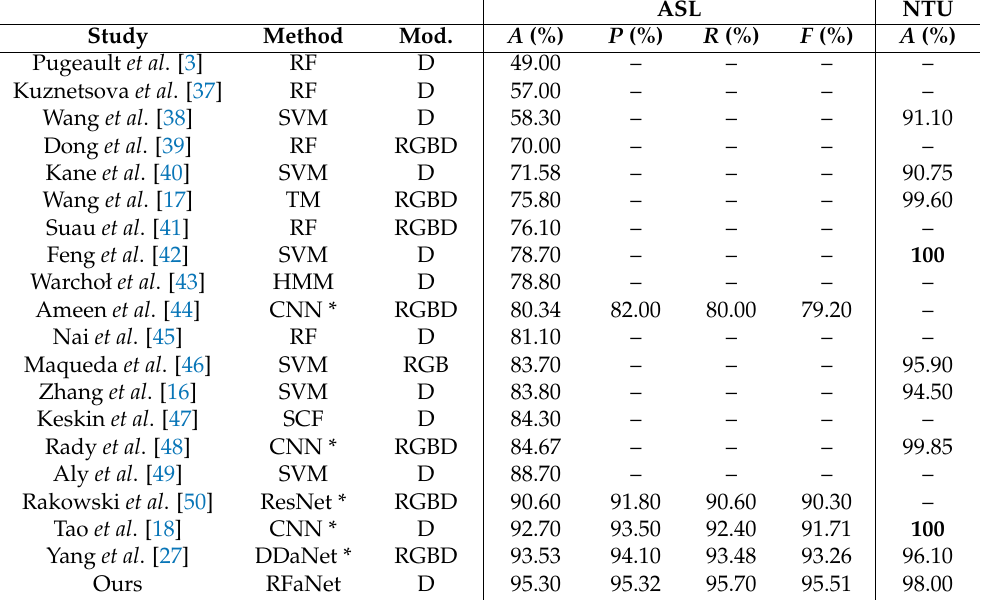
Table 4. Comparisons with state-of-the-art methods using LOOCV evaluation on the ASL and NTU datasets. The “Method” column shows the classifiers used in state-of-the-art methods, where * indicates that the feature descriptor and classifier are jointly trained in the method. Mod: modality; A : accuracy; P : precision; R : recall; F : F -score. Bold values indicate the highest classification accuracy among the state-of-the-art